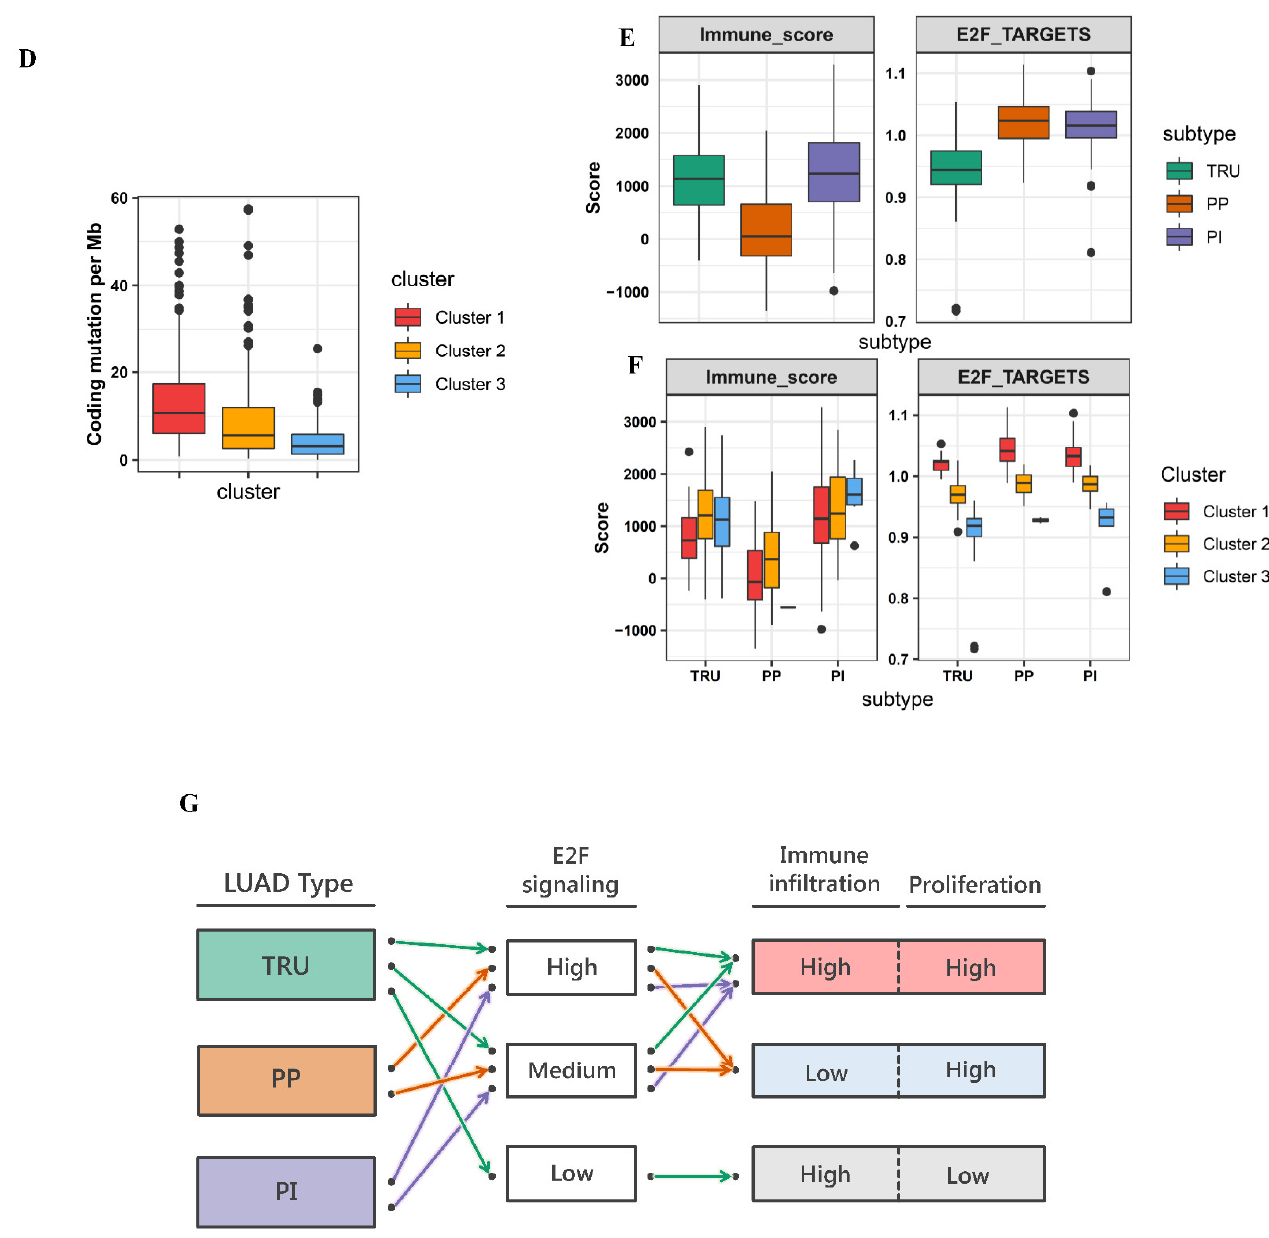
Figure 5. Drug discovery and immune characterization in essential gene-classified clusters of lung adenocarcinoma (LUAD). ( A ) Heatmap showing essential gene-stratified-clusters exhibiting distinct expressions in GDSC lung cancer cells. ( B ) Drug response area under the receiver operator characteristics curve (AUC) of SN-38 and talazoparib within essential gene- classified clusters demonstrated as a boxplot. ESTIMATE-derived immune infiltration ( C ) and the tumor mutation burden ( D ) were compared within each cluster and are shown as boxplots Boxplot of immune infiltration and E2F signaling within previously defined subgroups ( E ) and essential gene-classified clusters ( F ). ( G ) Integration of previously defined molecular types and essential gene-stratified clusters categorizing LUAD patients into distinct immune infiltration and proliferative signature groups. * means p < 0.05.